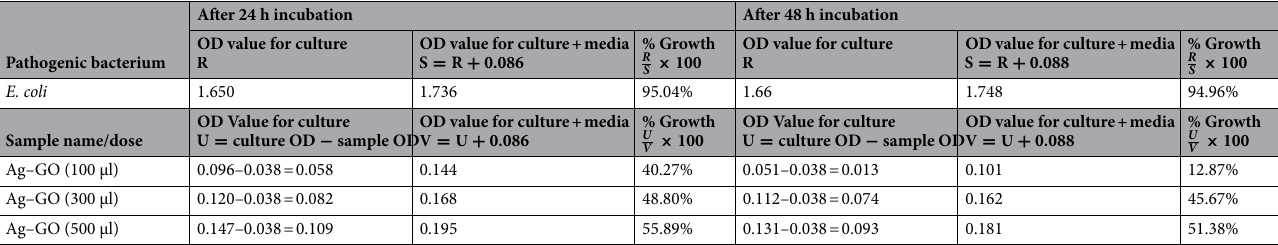
Table 3. Antibacterial activity effects of Ag–GO on E. coli.